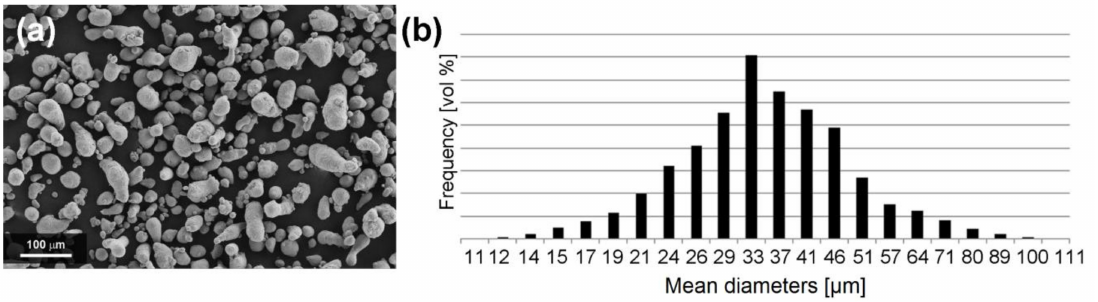
Figure 1. A357 alloy powder: ( a ) FESEM observation ( b ) laser granulometry analysis.